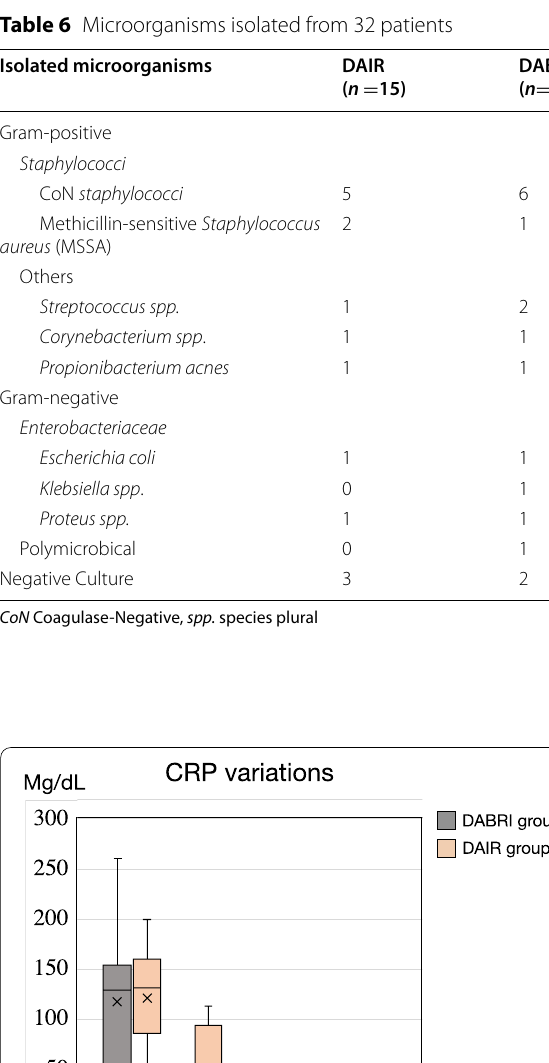
Table 6 Microorganisms isolated from 32 patients Isolated microorganisms